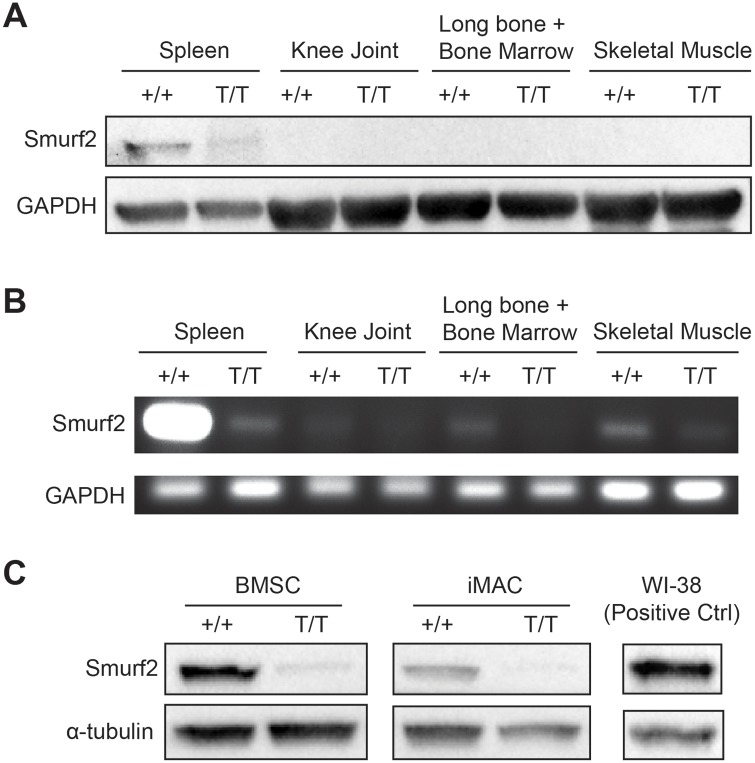
Smurf2 protein and gene expressions in WT (+/+) and Smurf2-deficient MT (T/T) skeletal tissues and primary cells.(A) Protein expression of Smurf2 in various skeletal tissues from healthy 4 month old male WT and MT mice. Spleen, where Smurf2 is highly expressed, is included as a positive control. (B) Smurf2 mRNA expression in various skeletal tissues compared to spleen in 4 month old male WT and MT mice. (C) Protein expression of Smurf2 in bone marrow stromal cells (BMSC, passage 0) isolated from 4 month old WT and Smurf2-deficient MT mice and immature articular chondrocytes (iMAC, passage 0) isolated from WT and MT neonates.